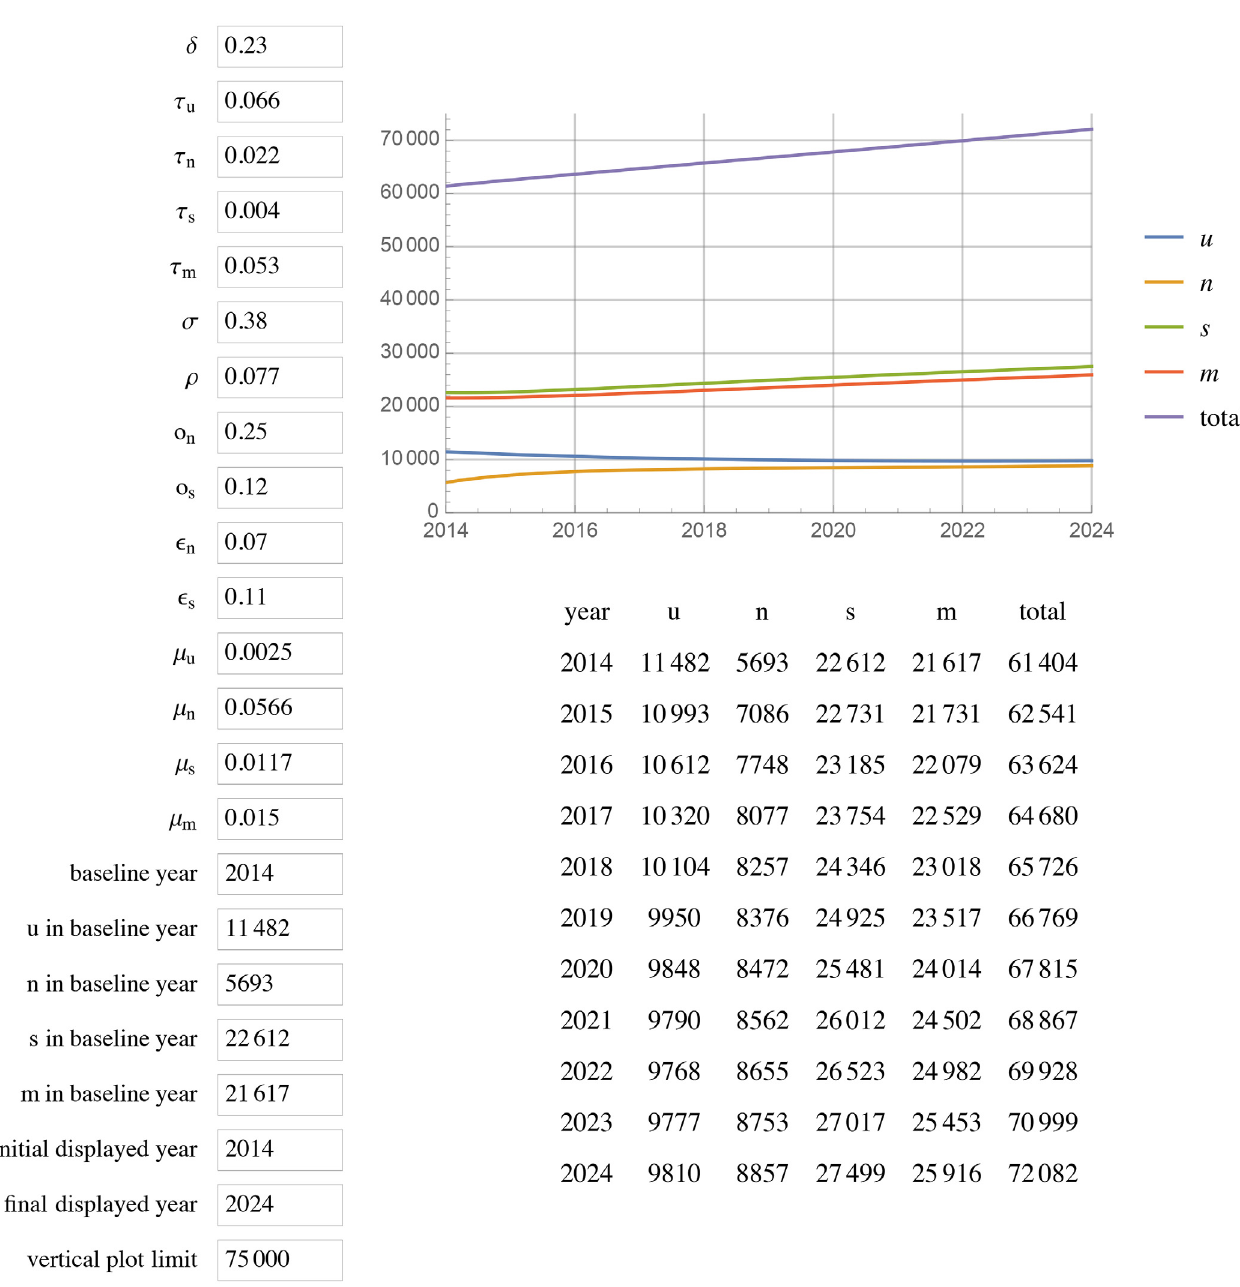
Fig 1. Status quo scenario. Current rates as of 2014 of diagnosis, transition between compartments, mortality, and HIV transmission estimates unchanged projected to 2024.